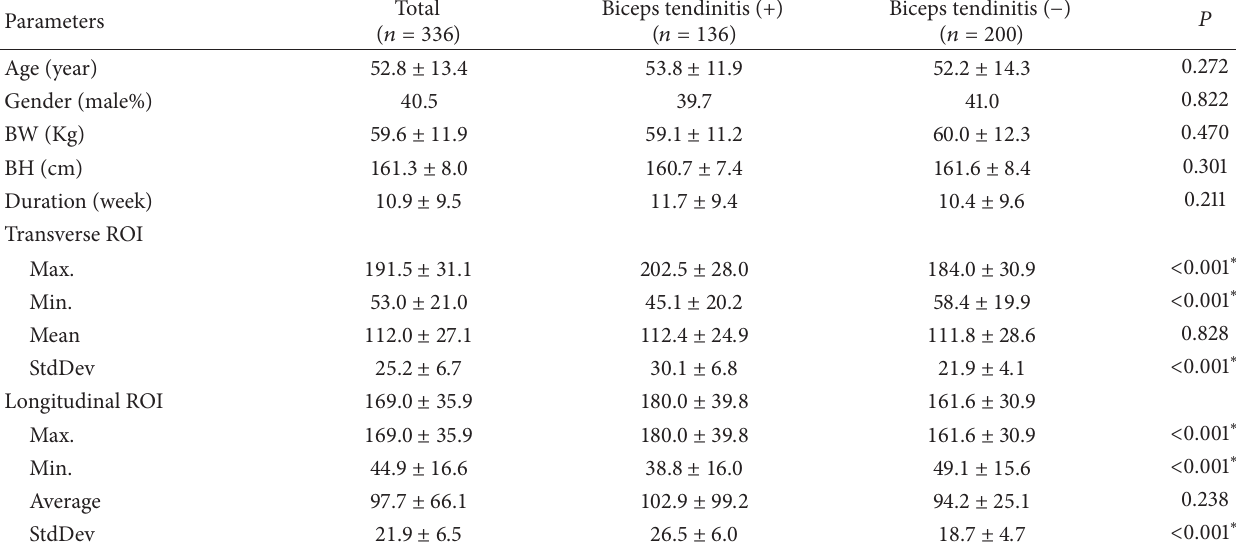
Table 1: Demographic data and ultrasonic quantitative parameters among biceps tendinitis and nonbiceps tendinitis groups.